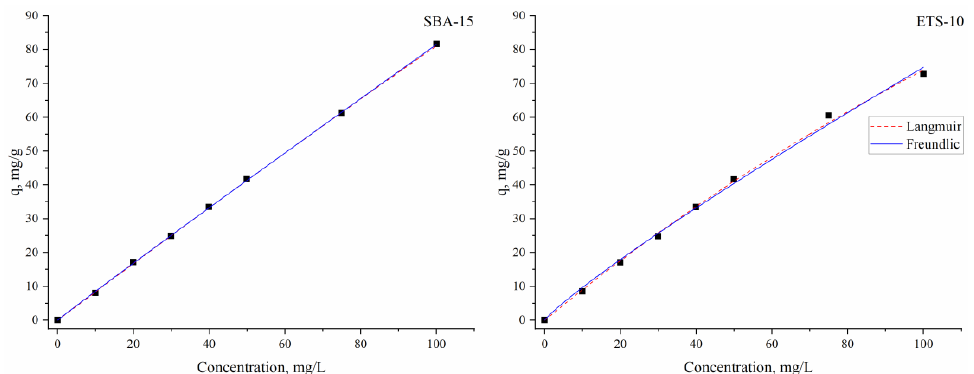
Figure 6. The equilibrium models describing indium ion sorption on silica SBA-15 and titanosilicate ETS-10 sorbents.